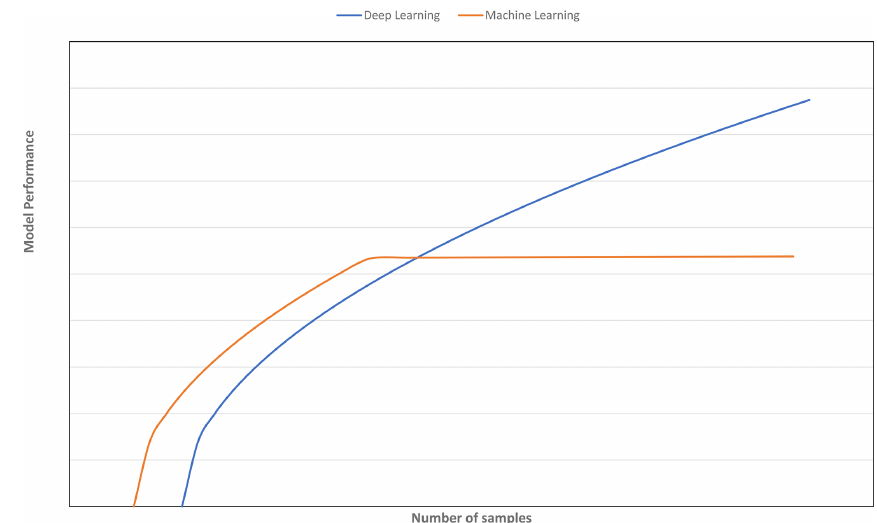
Figure 1. Model performance of deep learning vs. other machine learning algorithms as a function of number of samples.